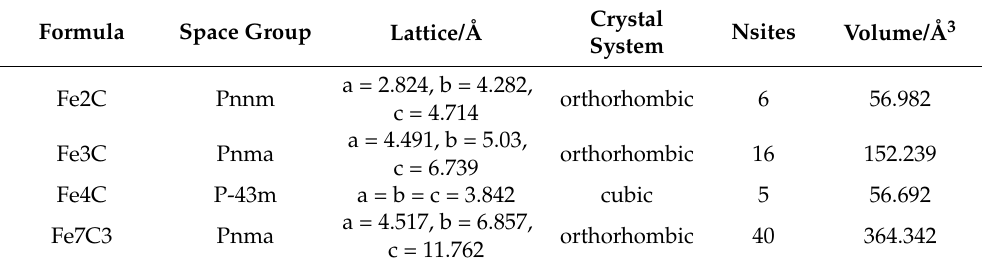
Table 1. Calculated parameters of carbide using MD.